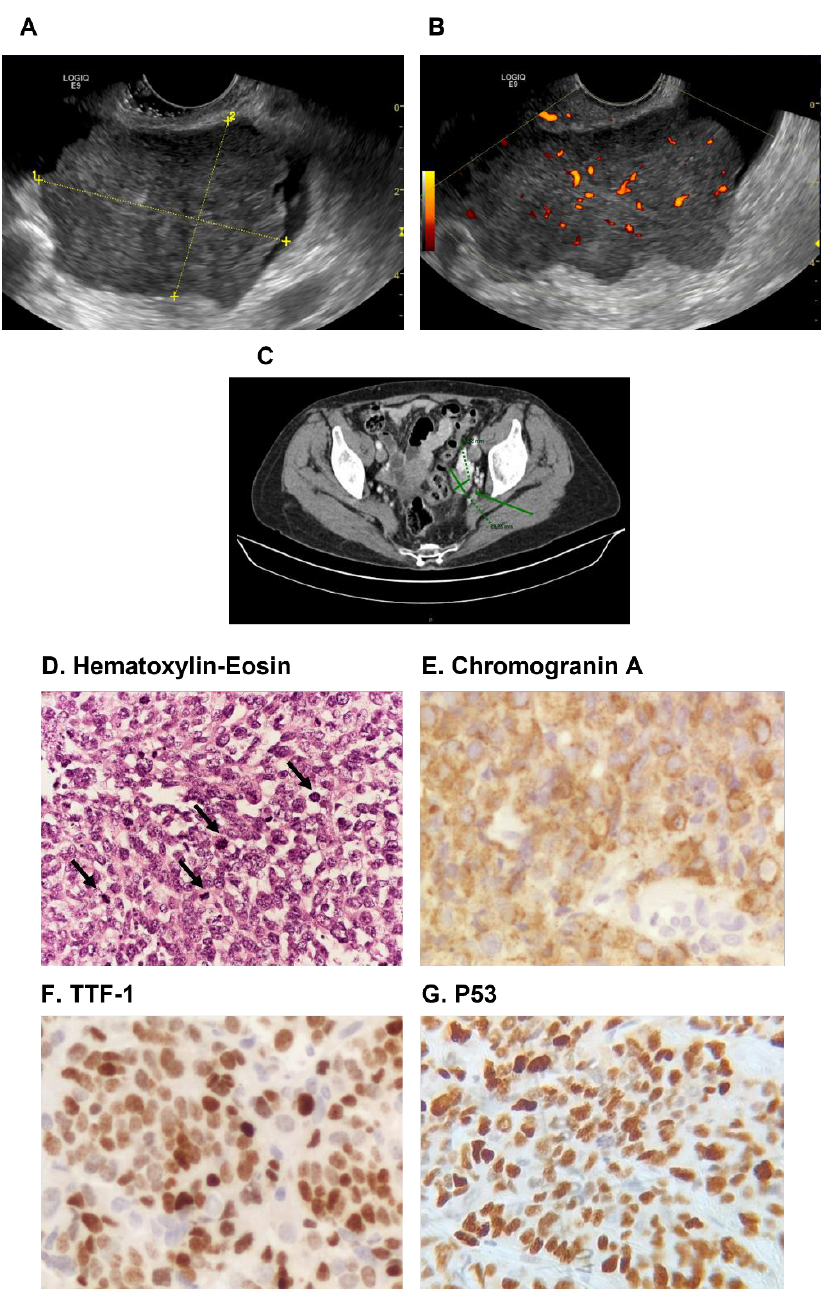
Figure 1. ( A ) Transvaginal ultrasound showing the left adnexal solid mass (7 cm), and ( B ) blood flow (CS 3) in the pelvic mass. ( C ) Abdominal CT scan showing the left ovarian mass after chemotherapy (green arrow). ( D ) Hematoxylin-Eosin staining showing tumor cells with scant cytoplasm and stippled chromatin (original magnification, 400×); black arrows indicate atypical mitotic figures. ( E ) Immunohistochemical positivity for chromogranin A, and ( F ) TTF-1 in SCCOPT (original magnification, 400×). ( G ) Immunohistochemical overexpression of p53 in SCCOPT (abnormal/mutation-type pattern; original magnification, 400×).